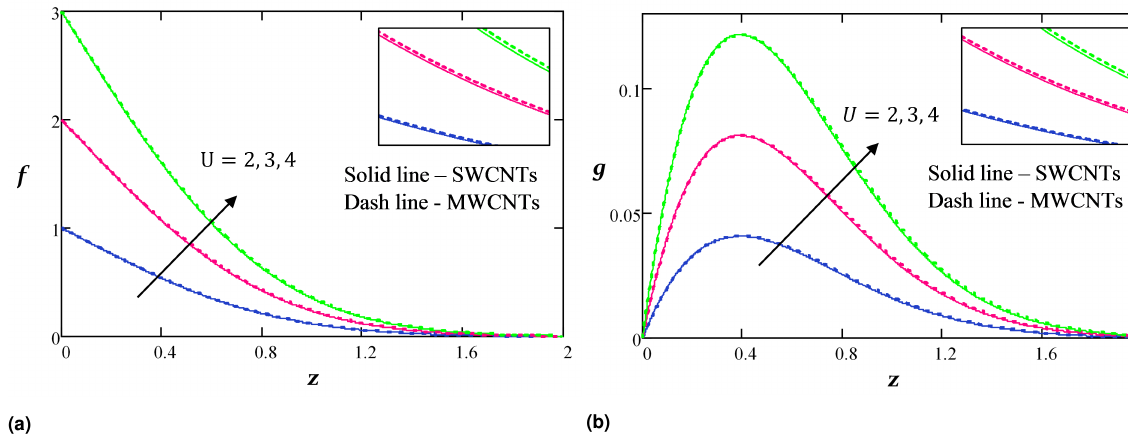
Fig. 7. f and g profiles under the impact of different U values.